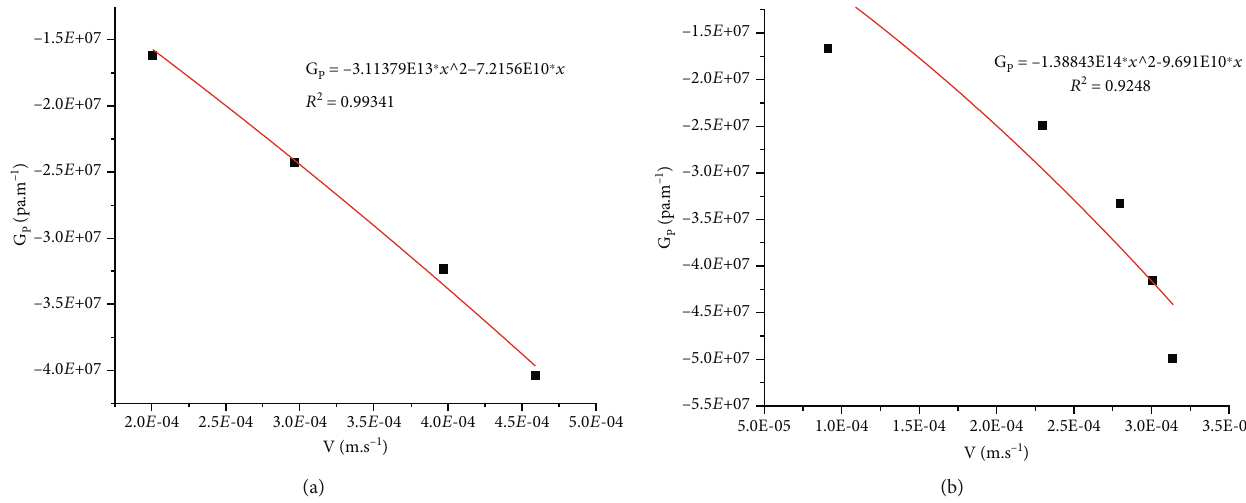
V of the fi lling gangues with a particle size of 5 ~ 10 mm at di ff erent axial loads: (a) 6 MPa and Figure 8: Fitted curves between G p and (b) 8MPa.